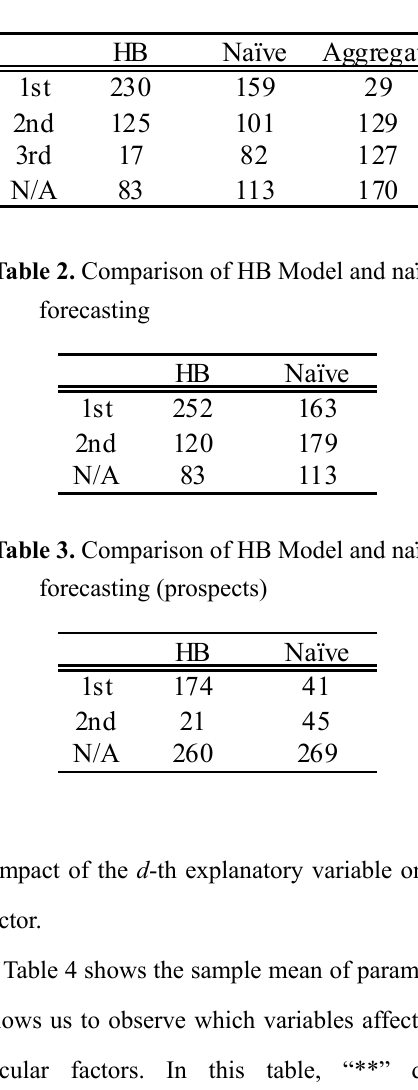
Figure 4. Area S Table 1. Rank of predictive performance